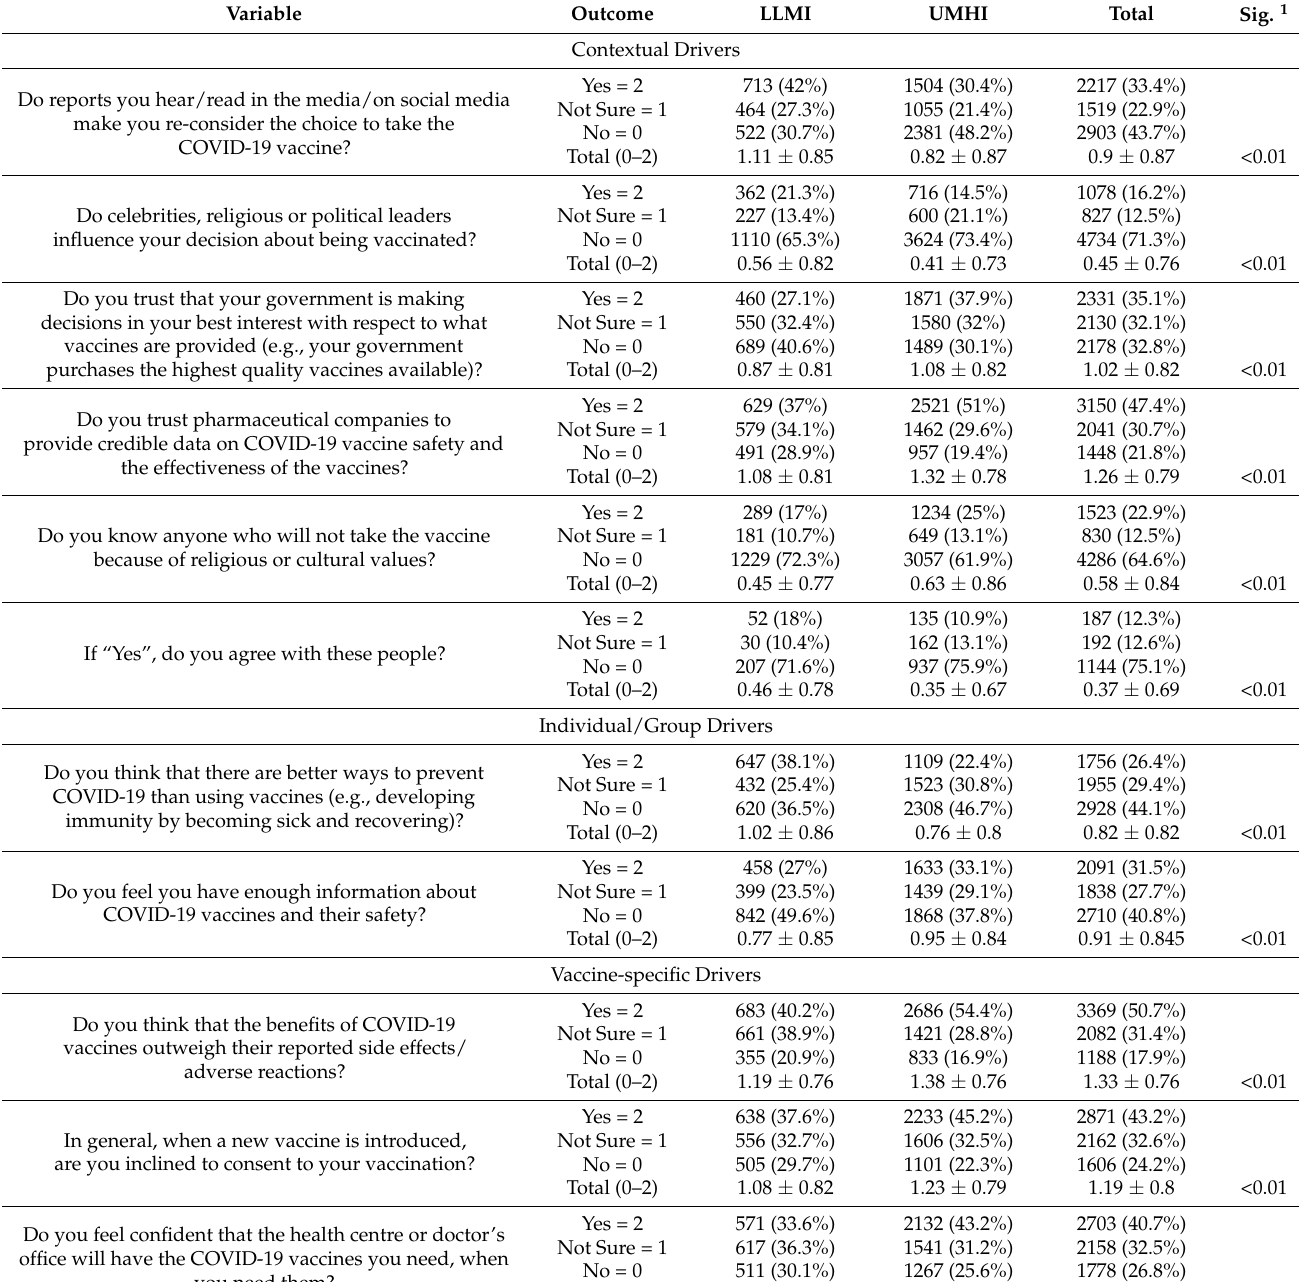
Table 5. Dental students’ vaccine-related attitude drivers stratified by economic level, February